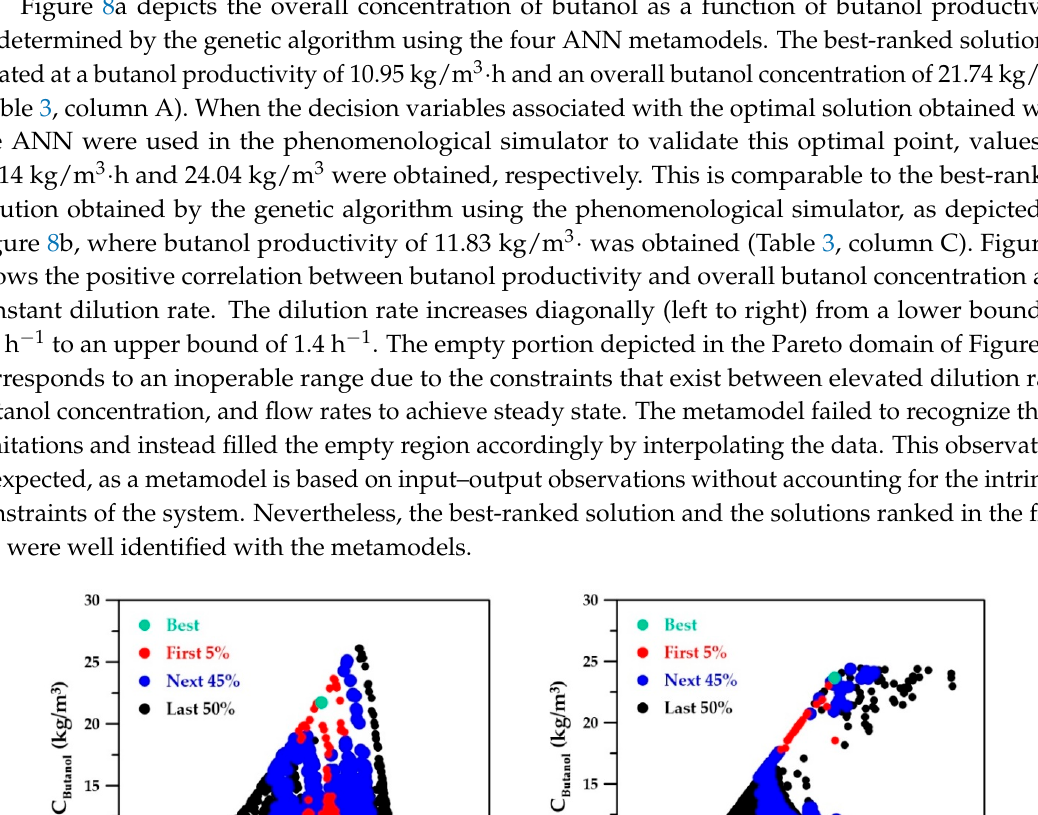
Table 2. Initial and reduced ranges of the decision variables.